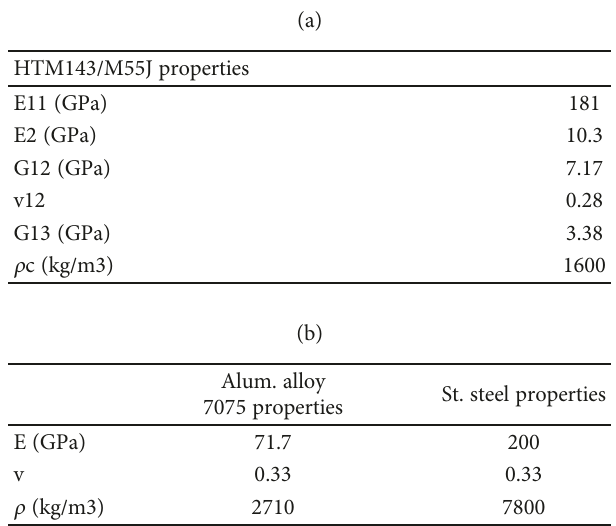
Table 1: Material